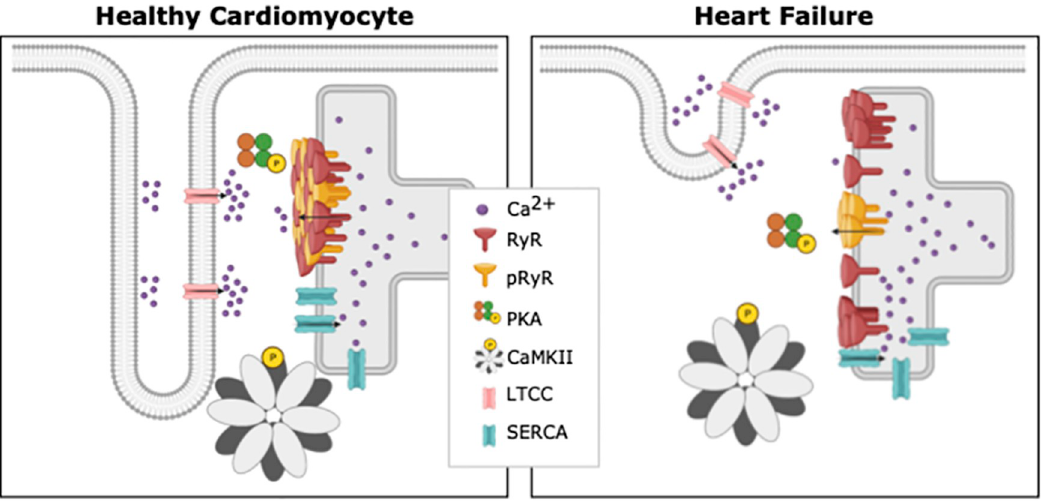
Fig 1. Differences between a healthy cardiomyocyte and a cardiomyocyte suffering from heart failure. Ca 2+ -induced Ca 2+ release occurs at units called dyads, where t-tubules and SR are in close proximity. In comparison with healthy cardiomyocytes (left), diseases such as HF have been linked to marked subcellular remodeling (right). Reported changes in failing myocytes include loss of T-tubule density, dispersion of RyR clusters, and changes in the spatial pattern of RyR phosphorylation. Created with BioRender